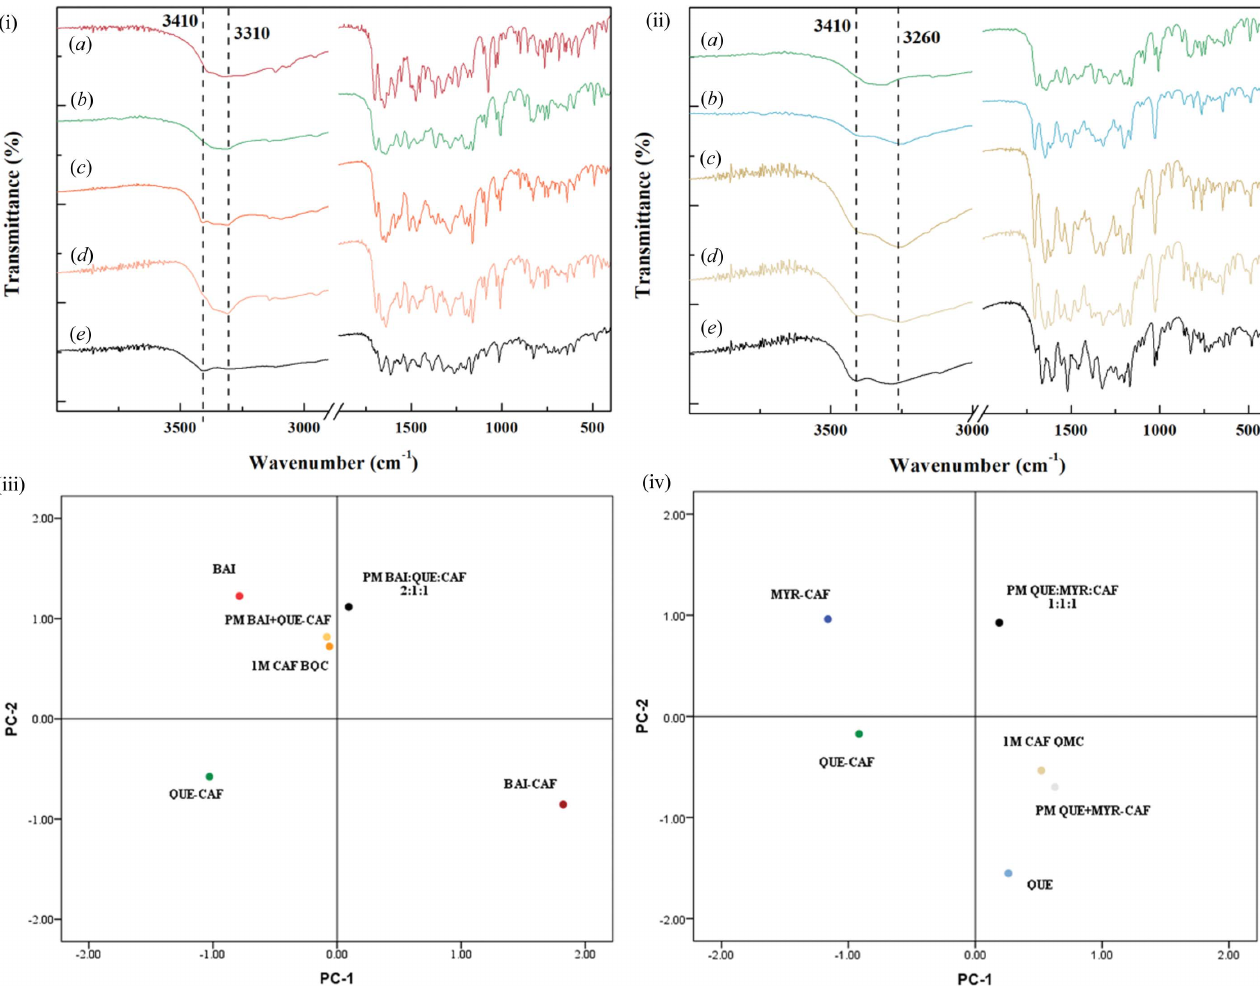
Figure 5 FT-IR spectra of the cocrystals (i)( a ) BAI–CAF, (i)( b ) and (ii)( a ) QUE–CAF, (ii)( b ) MYR–CAF; systems of (i)( c ) 1 M CAF BQC and (ii)( c ) 1 M CAF QMC prepared by slurry reaction experiments; physical mixtures of (i)( d ) BAI and QUE–CAF, (i)( e ) BAI, QUE and 1 M CAF, (ii)( d ) QUE and MYR– CAF, (ii)( e ) QUE, MYR and 1 M CAF. Principal component analysis scores plot of FT-IR data of the (iii) the BQC system and (iv) the QMC